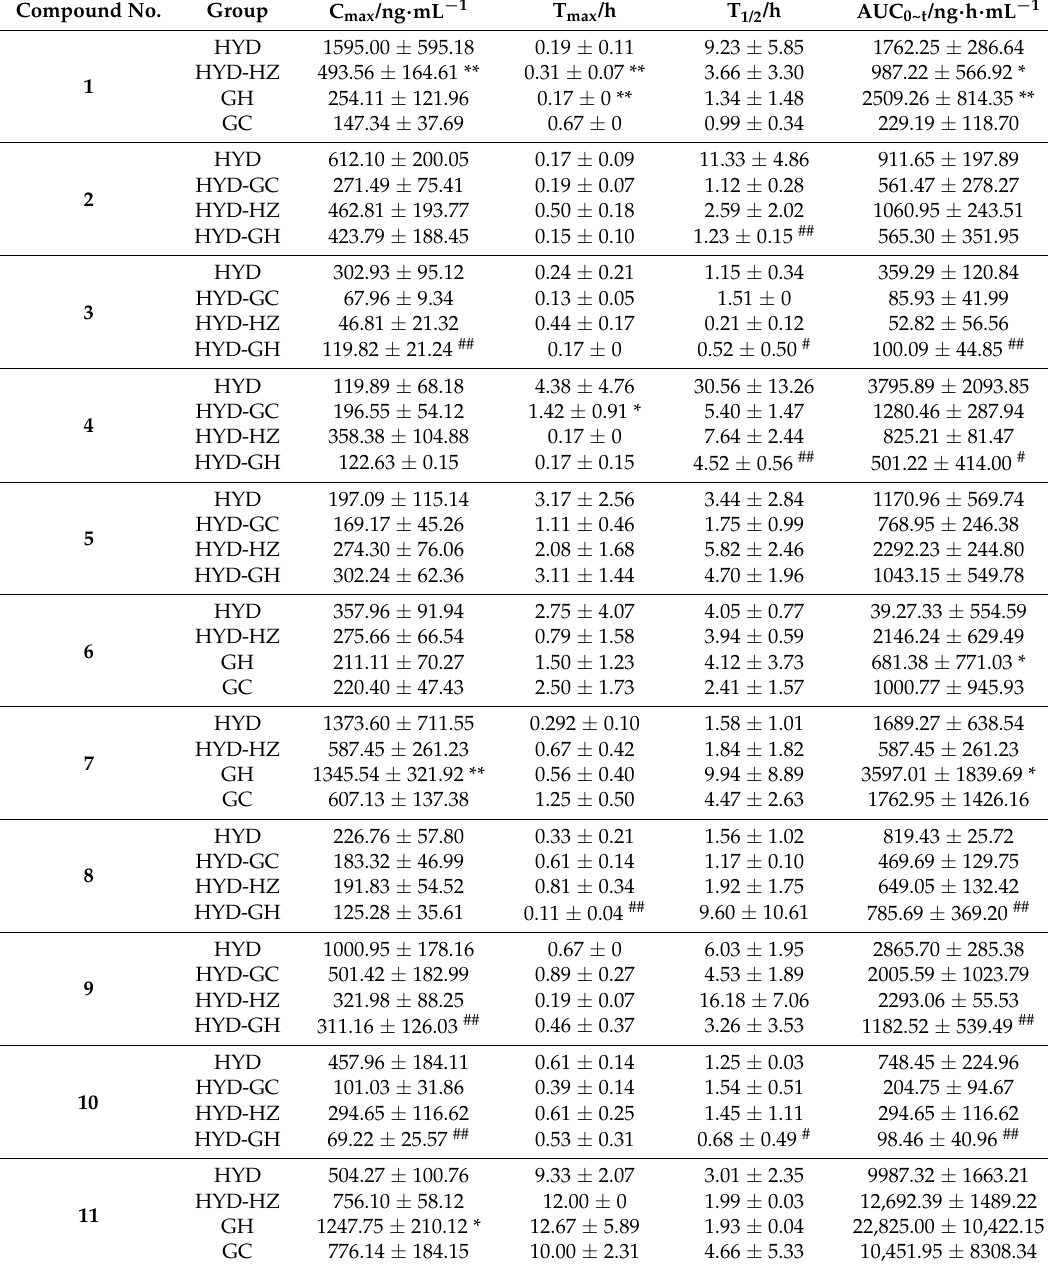
Table 6. Pharmacokinetic parameters of compounds 1 – 11 after oral administration of different decoctions in normal rats ( n = 6). Compound